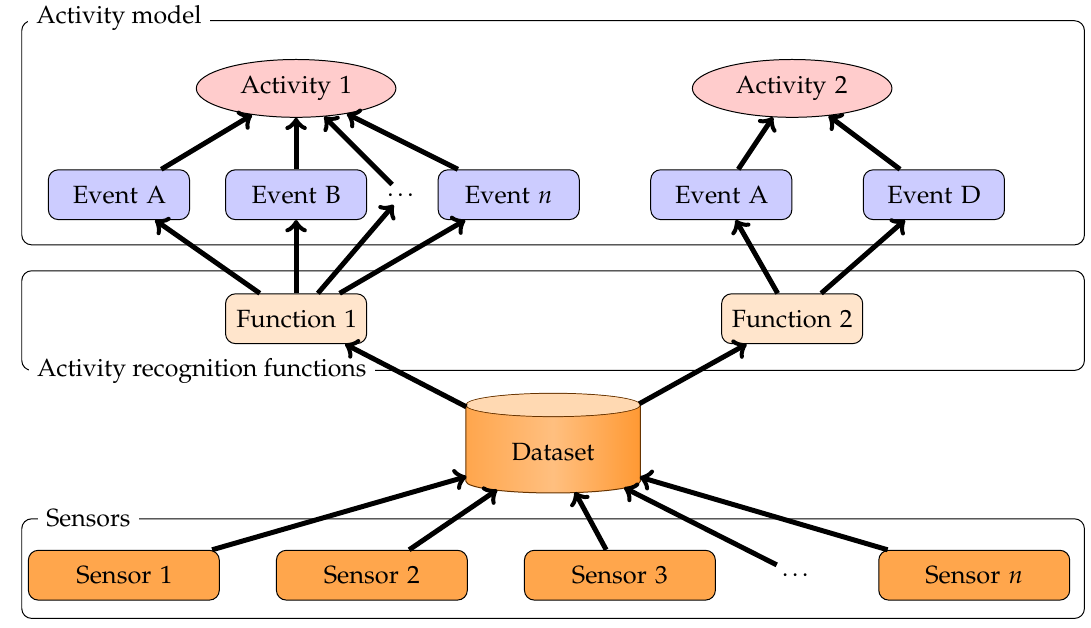
Figure 21. Split of activity in event and module that detects events through sensor data.